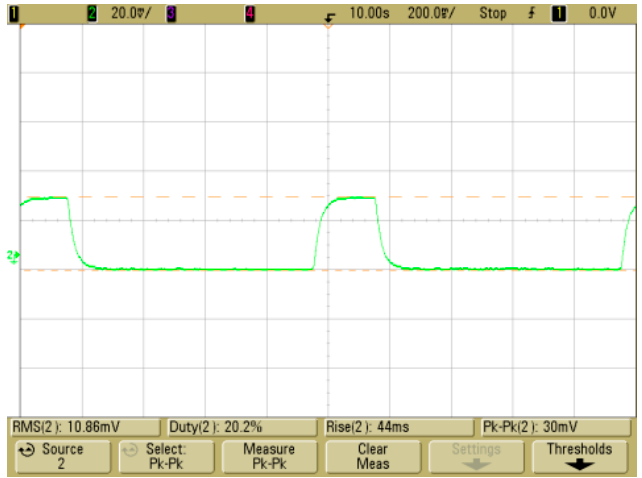
Figure 14. Accelerated high temperature/high moisture test result of the MEMS 2D wind direction and wind speed sensor applying both the two-layered upper protective coating and the PI lower protective coating.